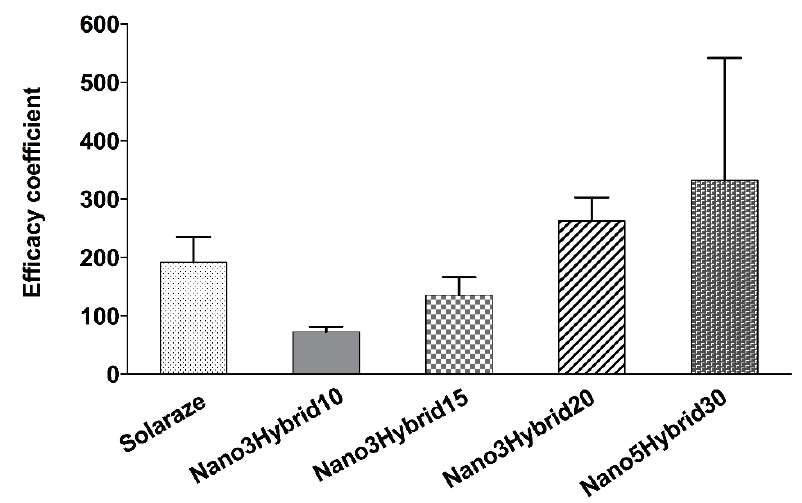
Figure 4. Efficacy of the drug retained in the skin related to its capacity to hinder the growth of EGF-stimulated HaCaT cells.